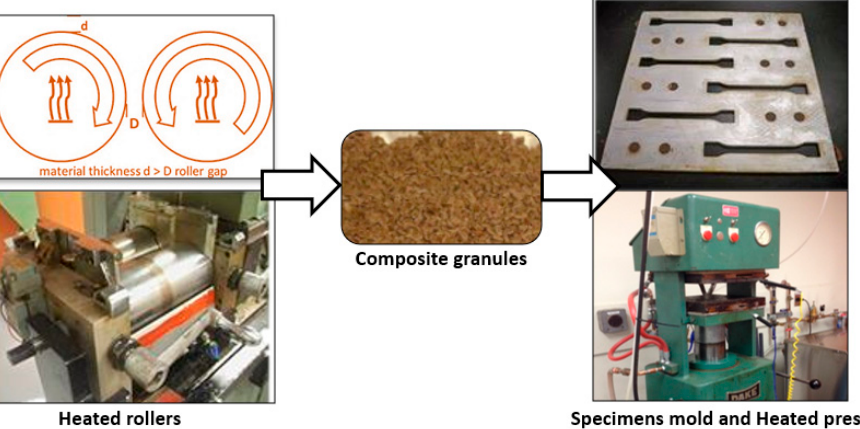
Figure 1. Summary of production process for composites and samples.